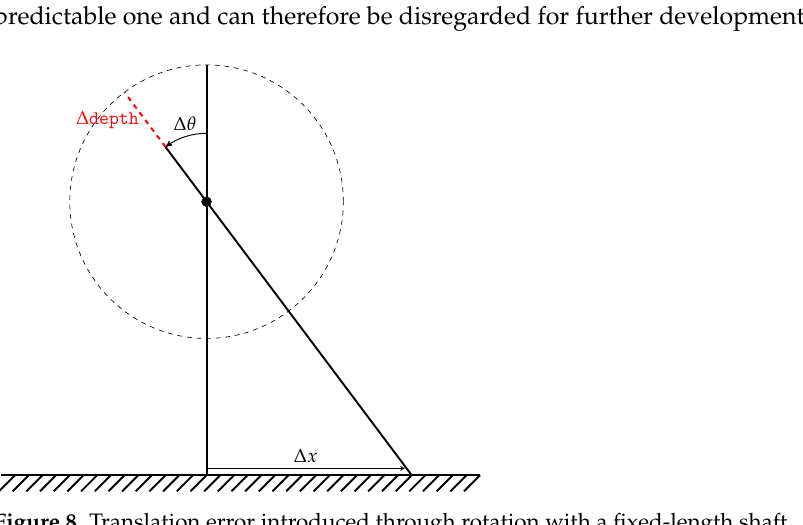
Figure 8. Translation error introduced through rotation with a fixed-length